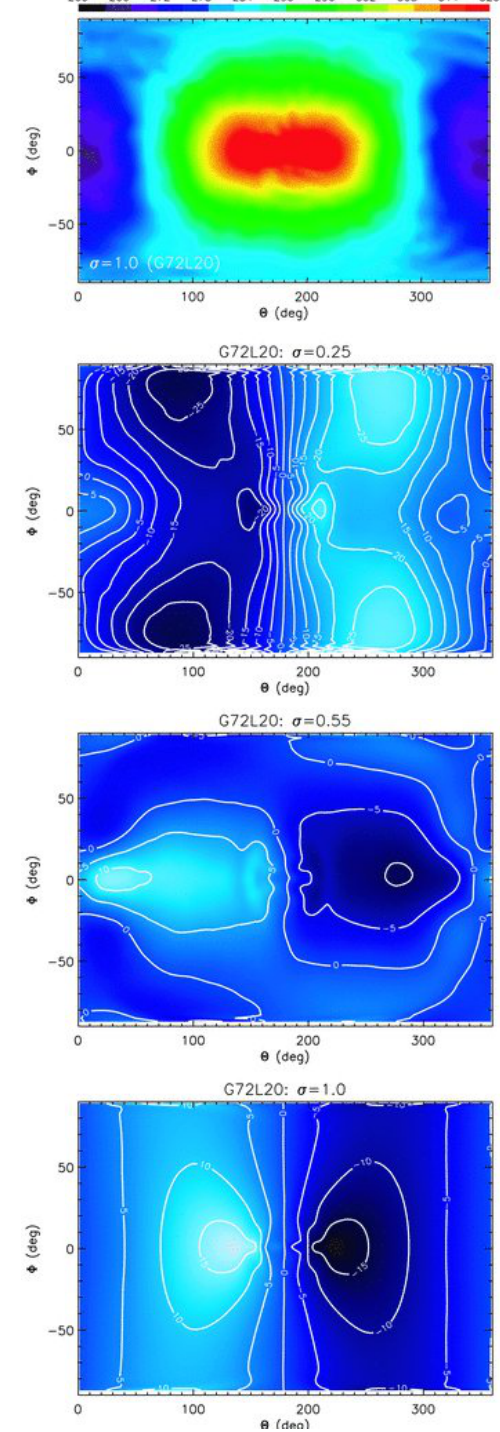
Figure 13. Figure reproduced from Heng et al. (2011b) of the re- Fig. 13. Figure reproduced from Heng et al. (2011b) of the results sults from the grid-based model of the TLE test case (reproduced from the grid–based model of the TLE test case (reproduced by per- with permission of Oxford University Press). Showing (from the top panel to the bottom panel) temperature at 1200 days and σ = 0 . 975, mission of Oxford University Press). Showing (from the top panel then, temporally averaged zonal wind at σ = 0 . 225, 0 . 525 and to the bottom panel ) temperature at 1200 days and σ = 0 . 975 , then, 0 . temporally averaged zonal wind at σ = 0 . 225 , 0 . 525 and 0 . 975 .